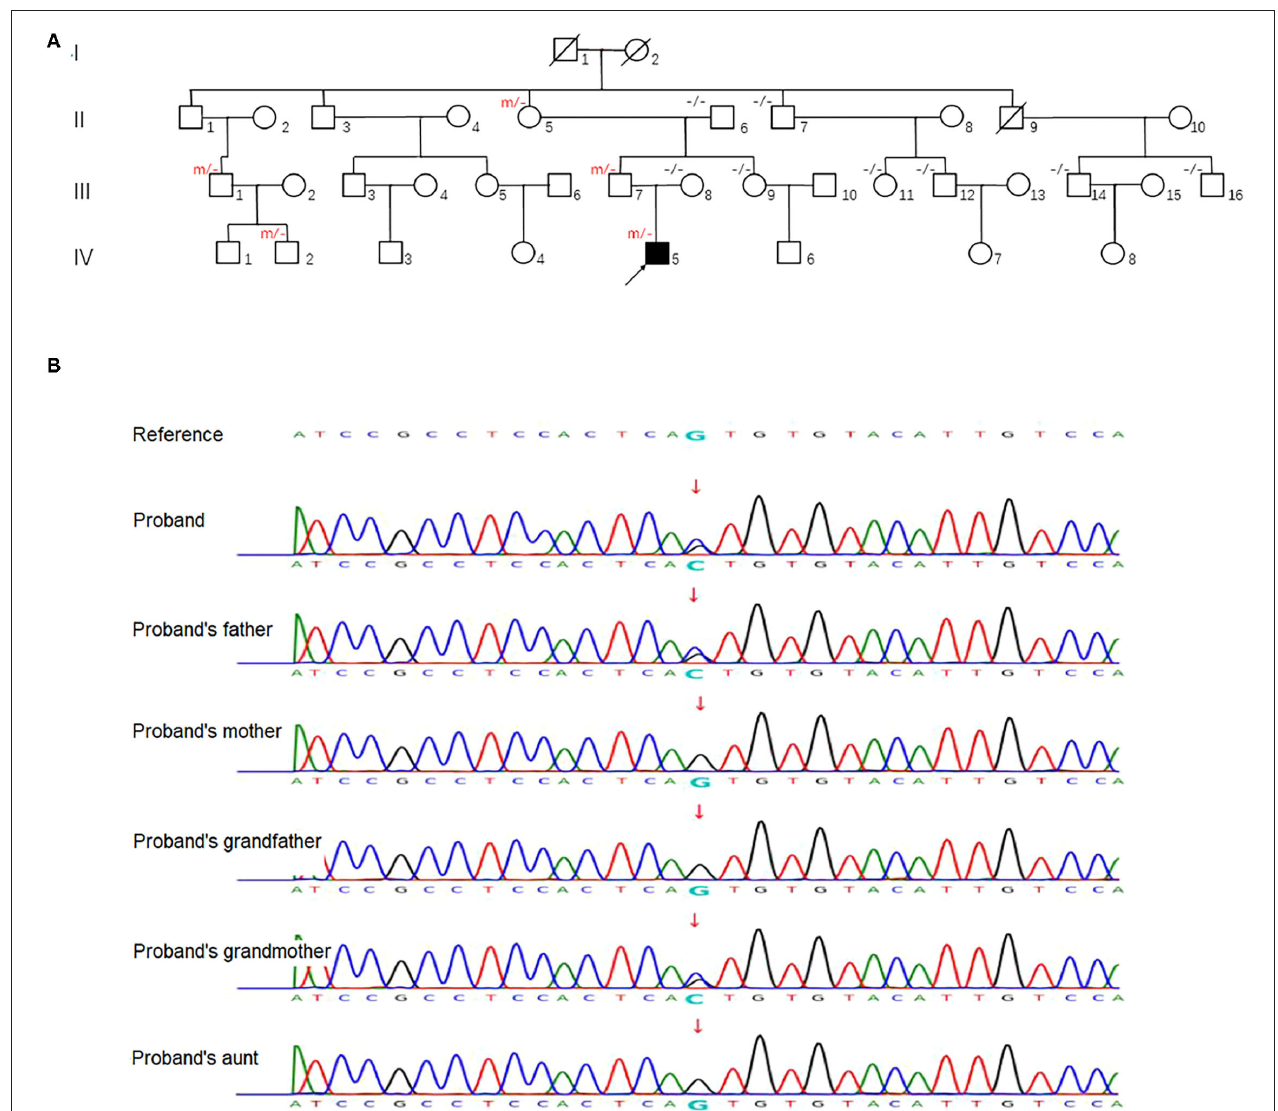
FIGURE 1 | (A) Family pedigree. An arrow denotes the proband. “m/–” and “–/–” in the upper left indicates ascertained UMPS heterozygous mutation carrier and wildtype subject, respectively. (B) Sequence analysis of human UMPS gene in the proband and his family members. Representative sequence electropherograms are shown.